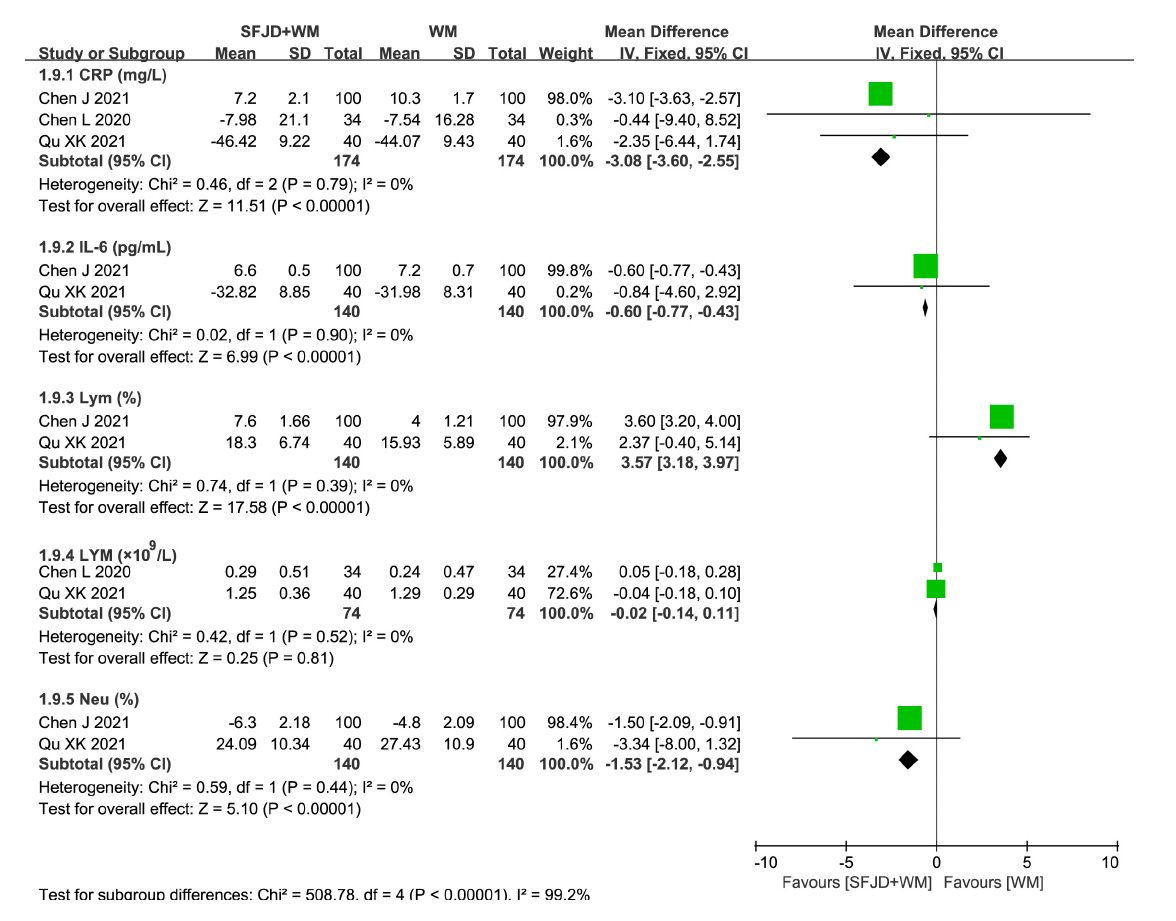
FIGURE9 Meta-analysis on laboratory outcomes in the SFJD + WM group vs. the WM group in COVID-19 patients (fixed effect model).